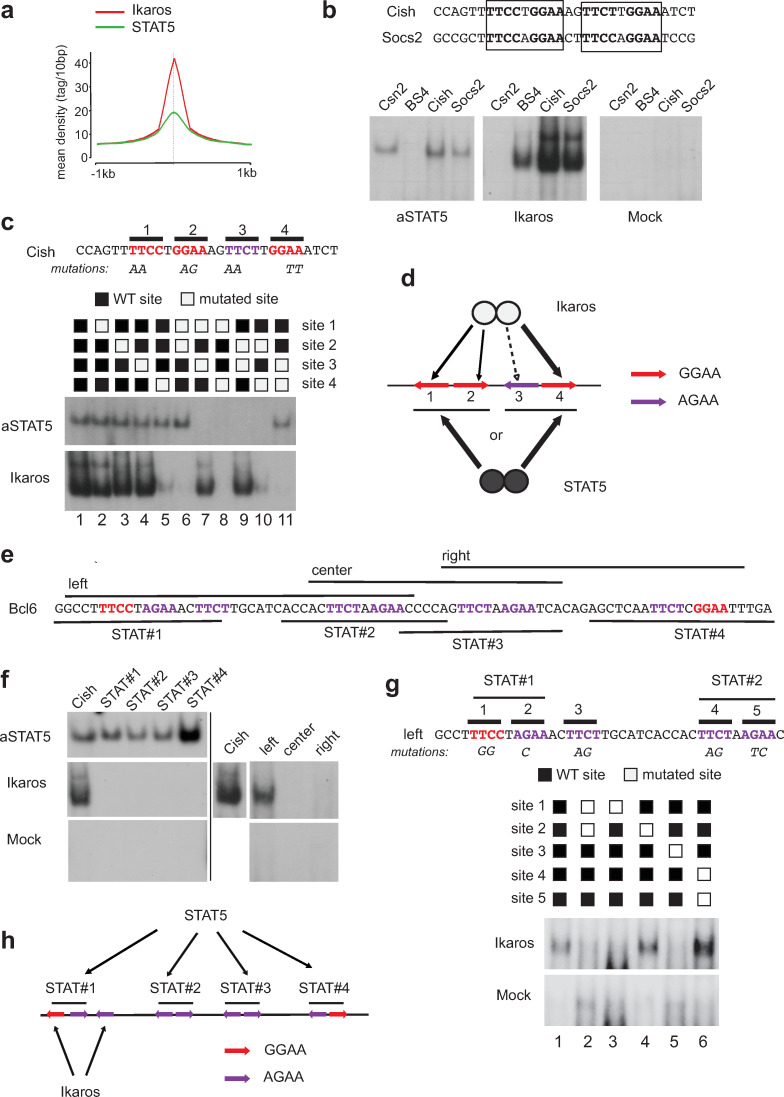
Ikaros and STAT5 target common sequences in the Cish and Bcl6 genes.(a) Tag density profiles of Ikaros and STAT5 on the 1163 genomic regions bound by both proteins by ChIP-seq. For both proteins, the curve is centered on the summit of the Ikaros peak. (b) Binding of Ikaros and the constitutive STAT5a mutant (aSTAT5) by EMSA to a conserved element present under the Ikaros/STAT5 peak summits in the Cish and Socs2 genes. Csn2 and BS4 are control probes known to bind respectively STAT5 or Ikaros. Mock corresponds to nuclear extracts from COS cells transfected with an empty expression vector. (c) Mutational analysis of STAT5 and Ikaros binding to the Cish probe (EMSA). (d) Schematic model of the binding of STAT5 and Ikaros dimers to the Cish element. (e) Sequence of the Bcl6 regulatory region under the summit of the STAT5 and Ikaros peaks. STAT5 target motifs are in red, and the various probes used for EMSA (in f) are indicated. (f) Binding of Ikaros and STAT5 to the Bcl6 regulatory regions. (g) Mutational analysis of Ikaros binding to the left probe. (h) Schematic representation of the binding of Ikaros and STAT5 to the Bcl6 regulatory region. The black lines represent the 4 STAT5 target sites. The original and uncropped EMSA autoradiograms are provided in S1 Raw images.